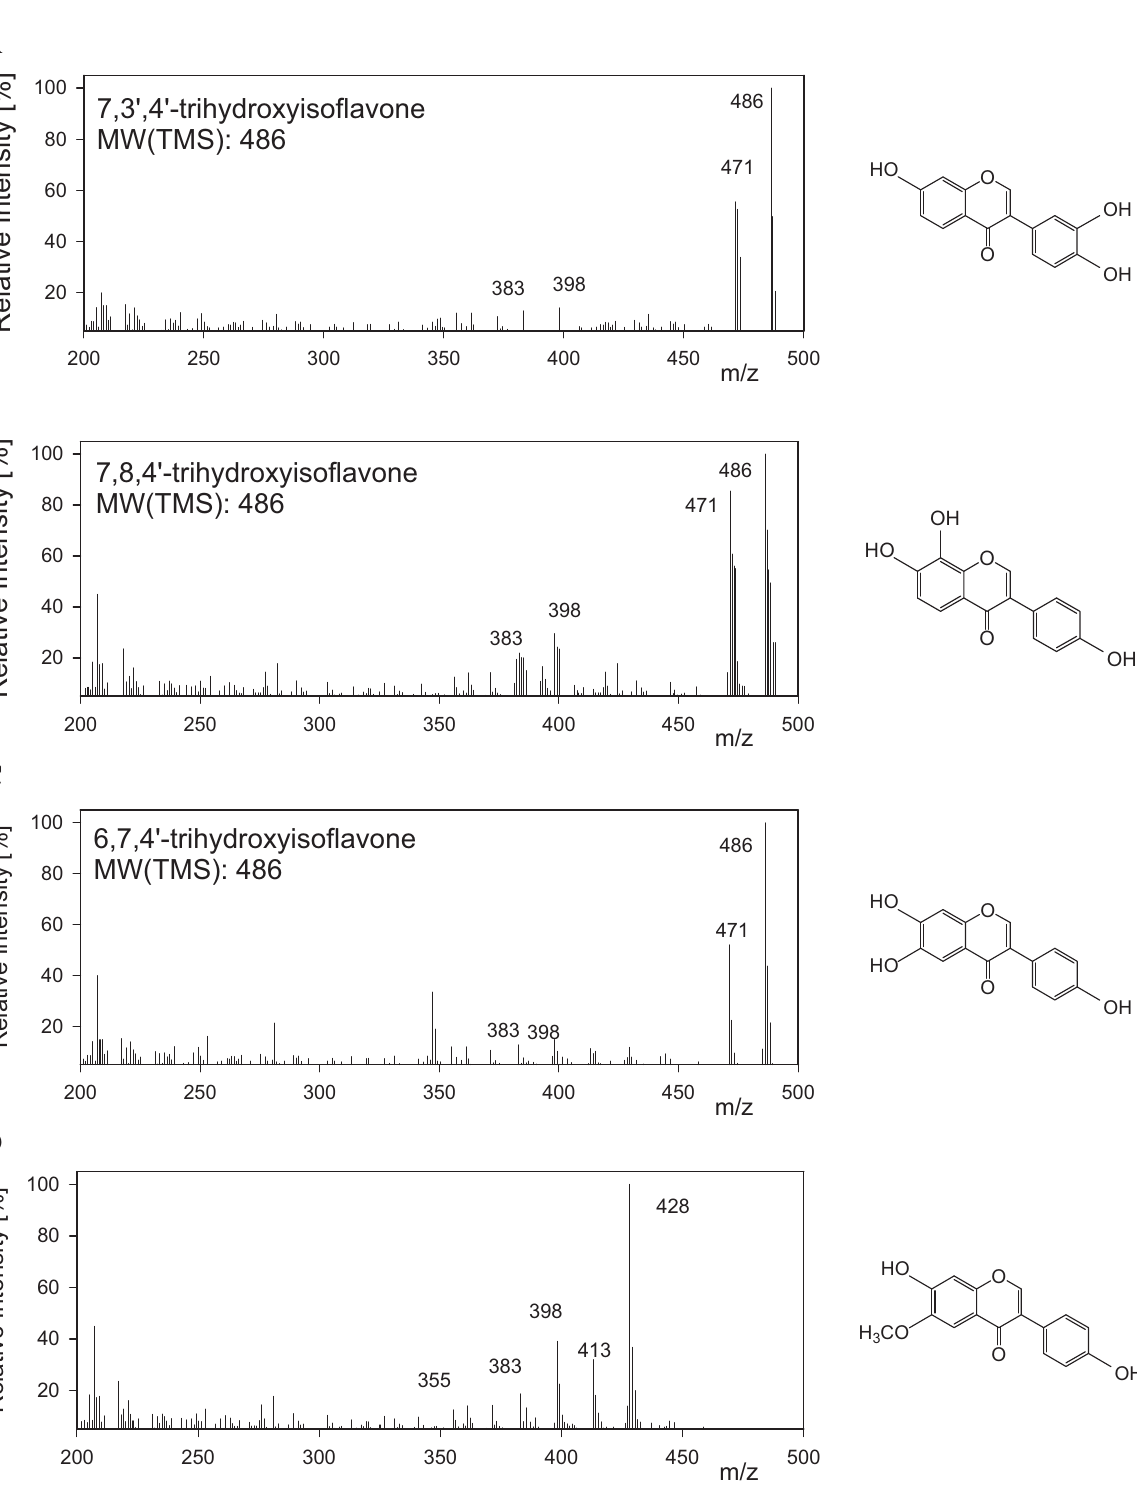
Figure 4. Mass spectroscopy analysis of daidzein hydroxylation from Bacillus subtilis Roh-1 and the chemical structures of TMS derivatives. ( A ) Mass spectra of metabolite, 7,3',4'-trihydroxyisoflavone; ( B ) Mass spectra of metabolite, 7,8,4'-trihydroxyisoflavone; ( C ) Mass spectra of metabolite, 6,7,4'-trihydroxyisoflavone; ( D ) Mass spectra of metabolite,